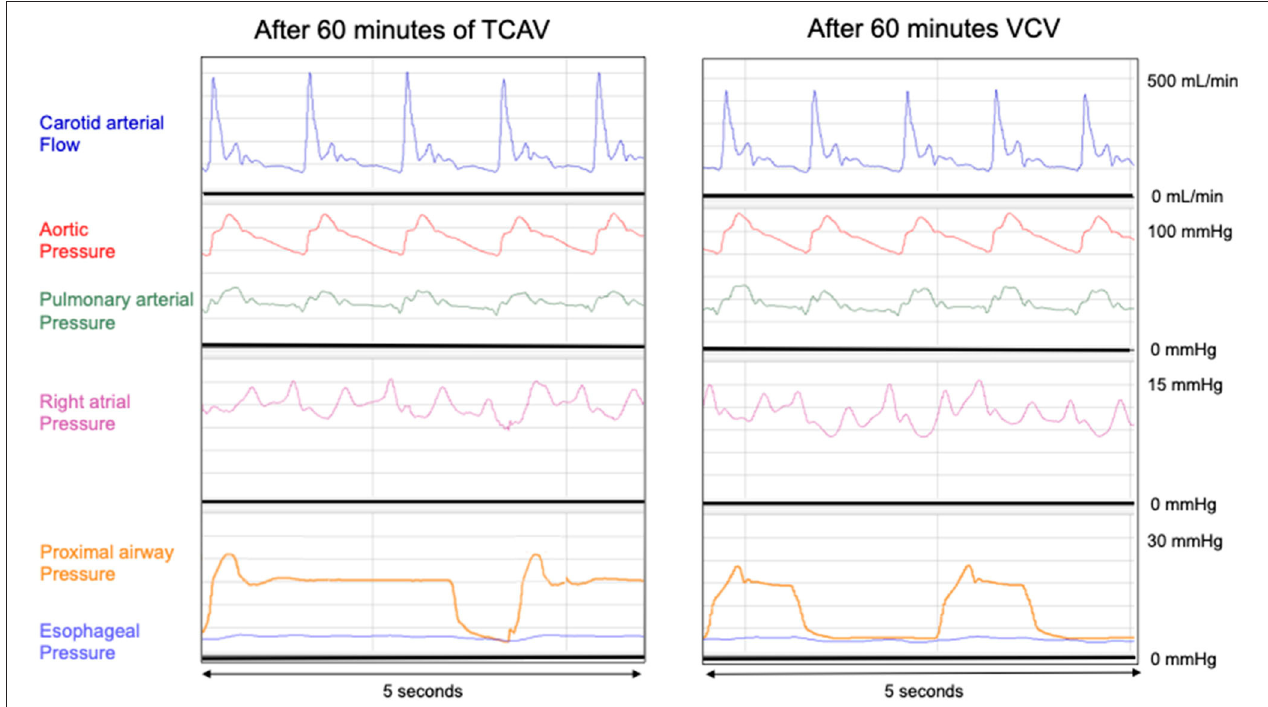
FIGURE 1 | Polygraphic recordings between two groups at T 60 of the main hemodynamic and respiratory outcomes. VCV: Conventional protective group with VT 6ml.kg − 1 , PEEP 10 cmH 2 O, RR 25 bpm, I:E 1:2. TCAV: Phigh 27 cmH 2 O, Plow at 0 cmH 2 O, Tlow 0.4s, Thigh 4.